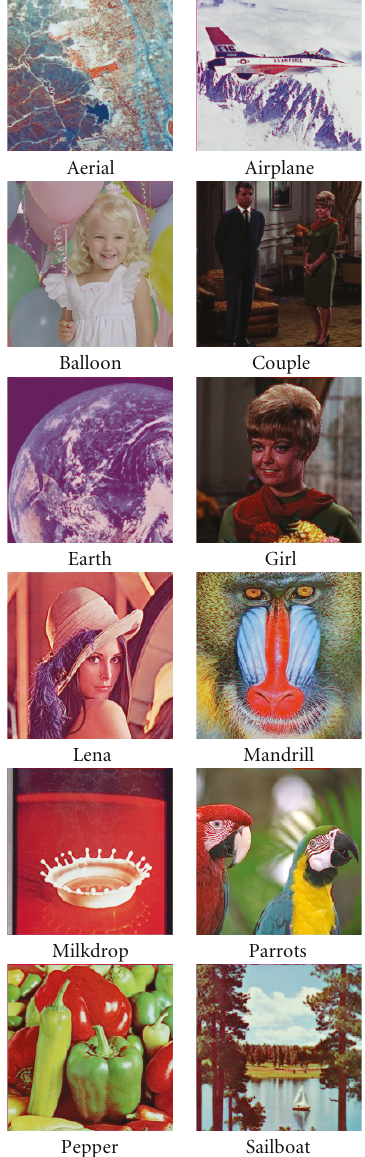
Figure 10: Lower limit images